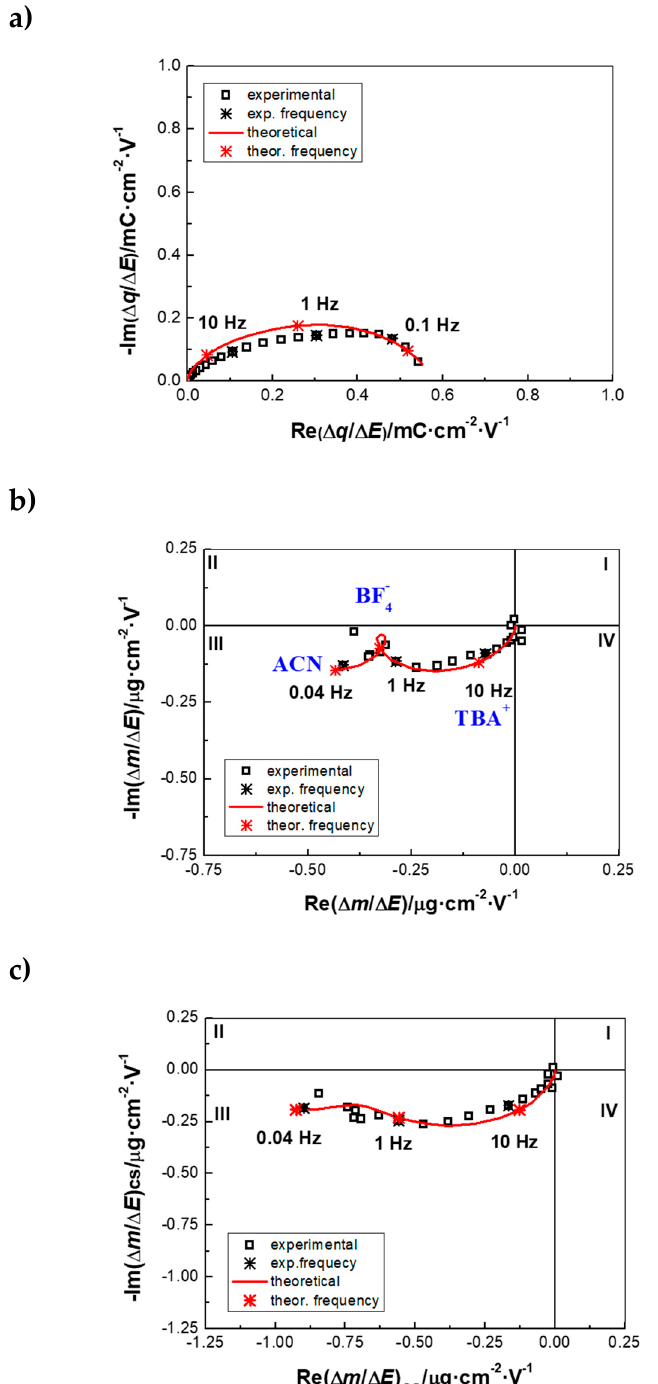
Figure 2. Ac -electrogravimetric data (experimental and fit) of PEDOT NWs in 0.5 M TBABF 4 in ACN at 0.4V vs. Ag / Ag + : ( a ) Charge / potential transfer functions (TF), ( b ) mass / potential TF and ( c ) partial mass / potential TF only for cation and solvent. Fitted parameters: K c : 4.634 × 0 − 4 , G c : 2.085 × 10 − 8 ; K a : 1.178 × 10 − 4 , G a : − 8.777 × 10 − 8 ; K s : 1.492 × 10 − 5 , G s : − 2.91 × 10 − 9 (c: TBA + , a: BF 4 − and s: ACN). AC–EG is a coupling of QCM with electrochemical impedance spectroscopy (EIS), in lieu of cyclic voltammetry (CV) in the EQCM.